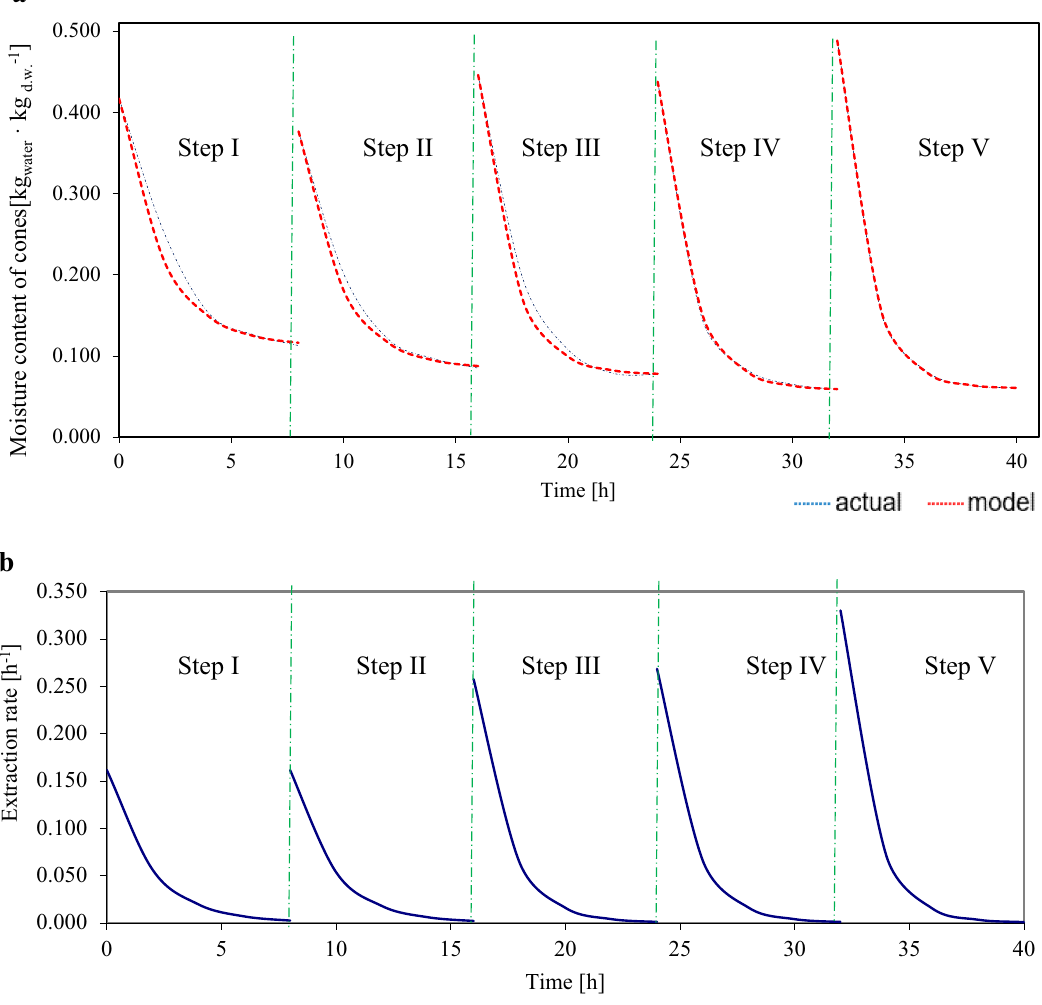
Table 6 gives mean scale and seed numbers per larch cone (with standard deviations) for the various extraction variants and homogeneous groups. On average, 70% of the seeds were extracted from cones used in all nine study variants, with 30% of the seeds remaining in the cones. Table 7 shows the number of seeds extracted in individual variants and the number of seeds remaining in the cones, expressed as a percentage.